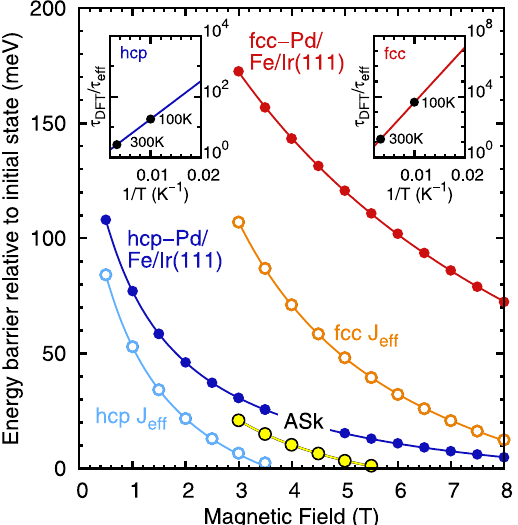
Figure 6. Energy barriers of skyrmion collapse vs. magnetic field and skyrmion lifetime enhancement. The energy barriers of isolated skyrmion collapse are shown as a function of applied magnetic field for the full set of DFT parameters as well as for the effective NN exchange model. The energy barriers of isolaed antiskyrmions which are metastable in fcc-Pd/Fe/Ir(111) using the DFT parameters are also displayed. The energy barriers are defined with respect to the initial states of isolated skyrmions or antiskyrmions. The inset shows the temperature dependence of the skyrmion lifetime enhancement τ DFT / τ eff obtained from the energy barrier difference between DFT and effective parameters. Since the energy difference varies only by a few meV with field we take the values 72 meV for fcc ( B = 4 T) and 25 meV for hcp ( B = 1.5 T) stacking of